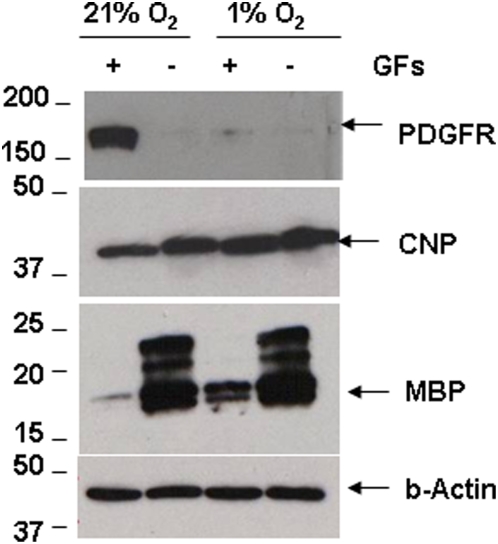
Hypoxia mediated acceleration of OL maturation.Cell lysates of OLs in 21% and 1% O2 for 1 week with GFs were analyzed by immunoblotting. Representative image shows decreased PDGFRα and increased MBP expression in 1% O2, and in cultures without GFs. β-actin loading control shown in bottom panel.